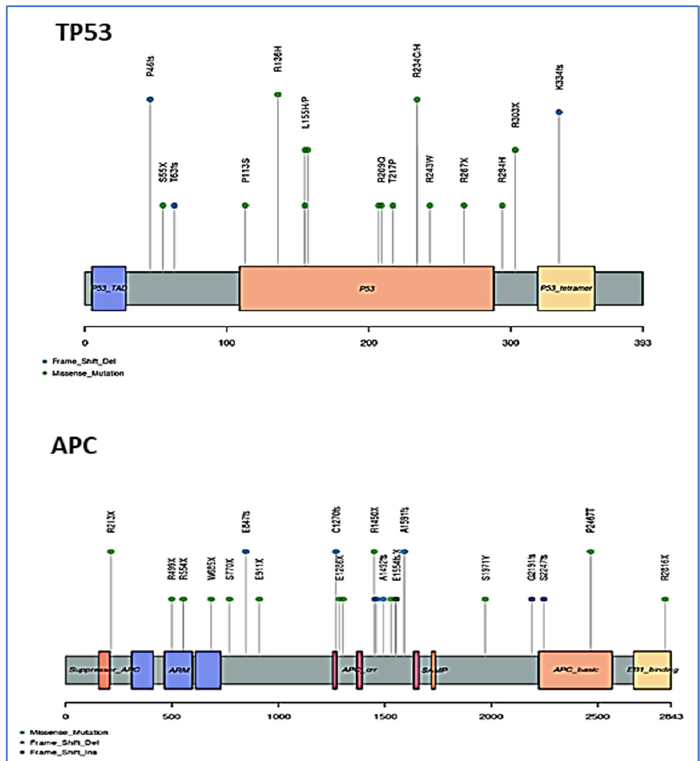
Figure 3. Schematic representation of detected somatic mutations in the TP53 and APC proteins. Frequent mutations in the TP53 at both transactivation and prolin rich regions. Frequent mutations in the APC protein are at the β -catenin binding and down-regulation site. The mutations are colored with respect to their type (missense, frameshift insertion, and frameshift deletions). Table 1. Highly frequent somatic mutations detected in the CRC group and in the CP or the IBD group.